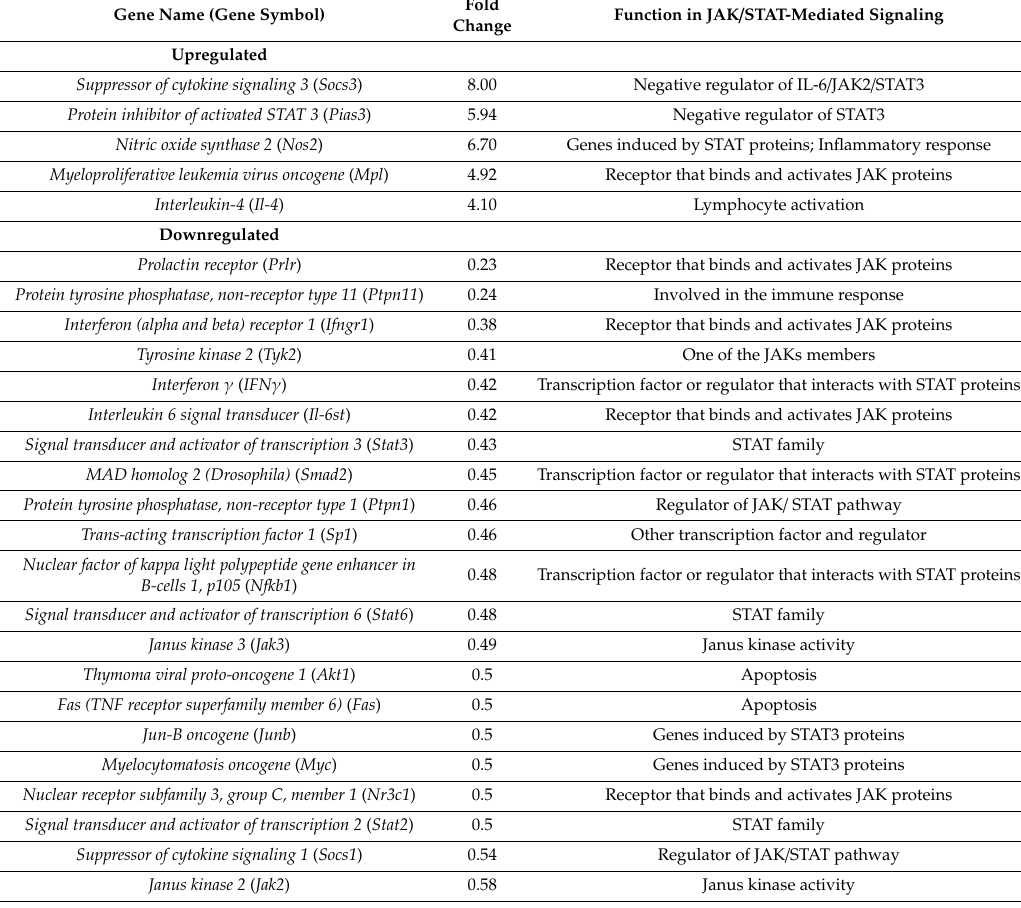
Table 1. Genes that were upregulated or downregulated by